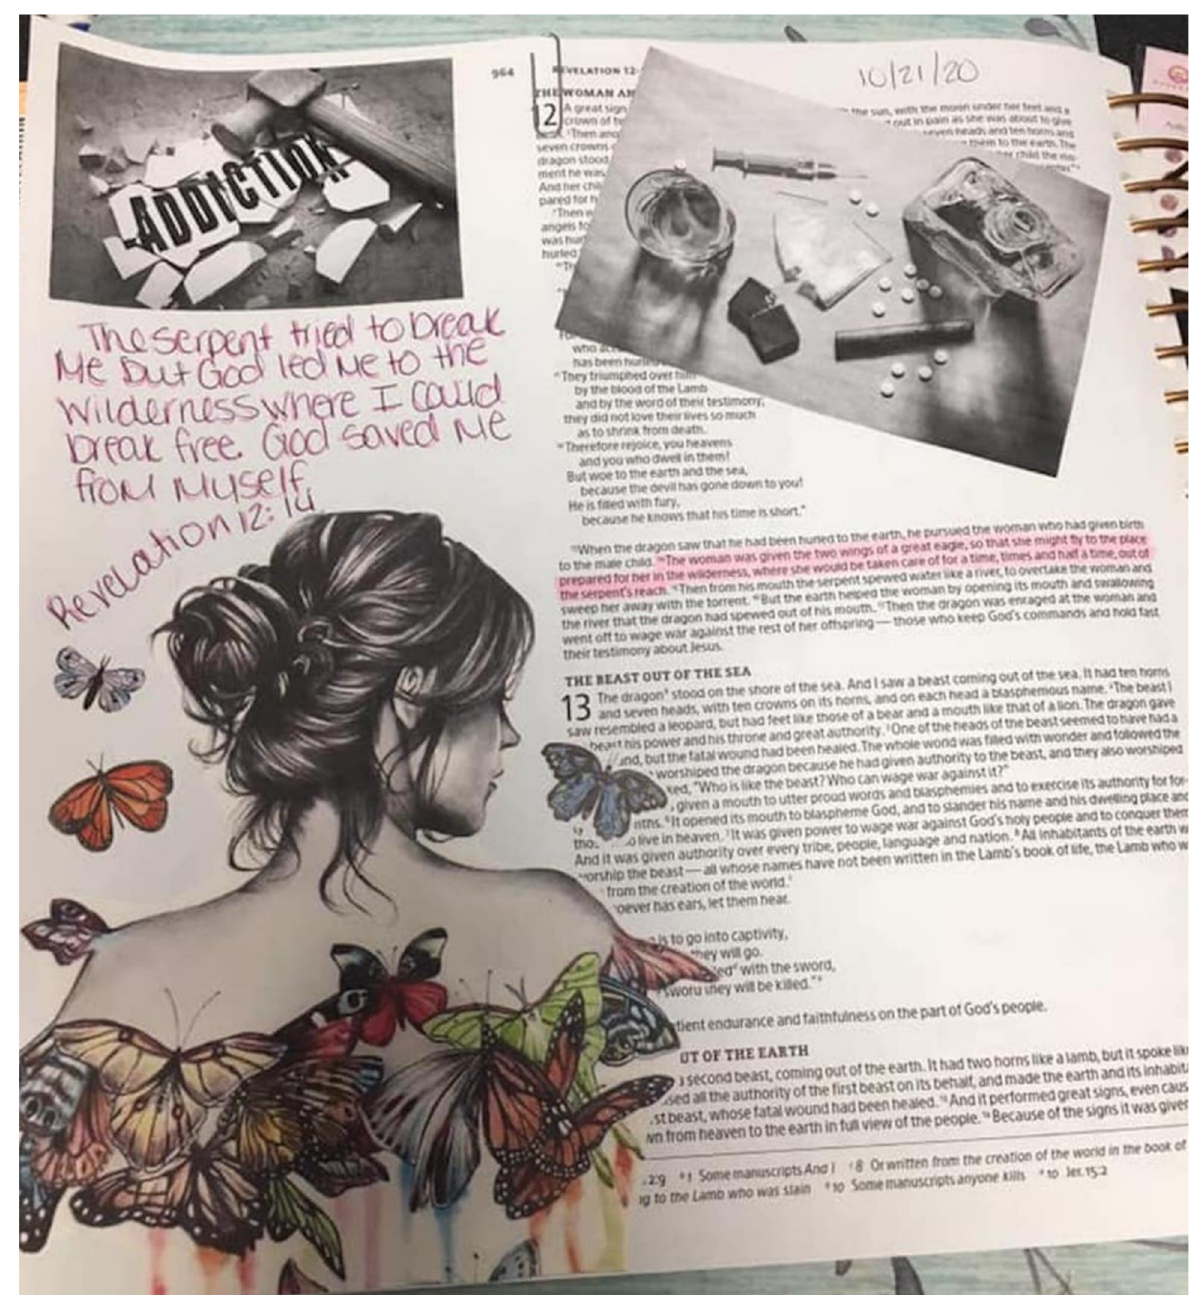
Figure 7. Revelation 12:14. With kind permission of the journaler.